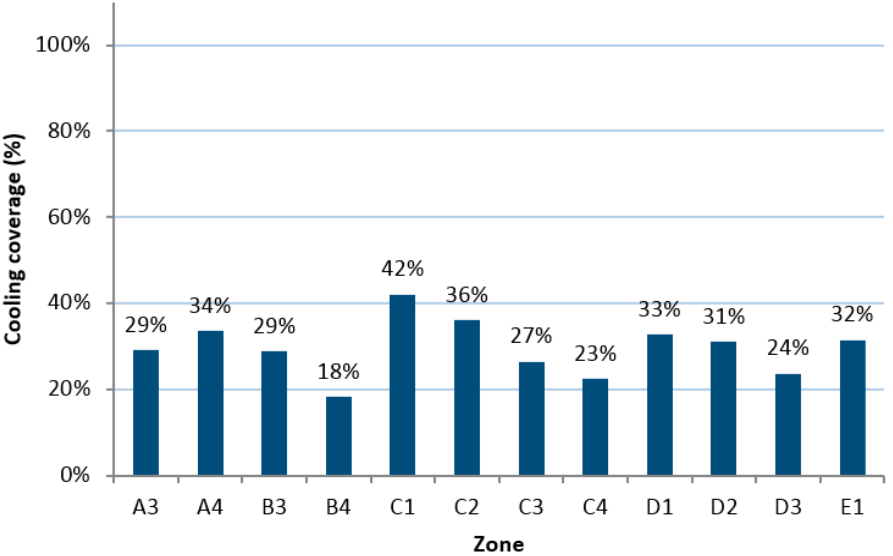
Figure 12. Annual cooling coverage comparison for the different climatic zones.